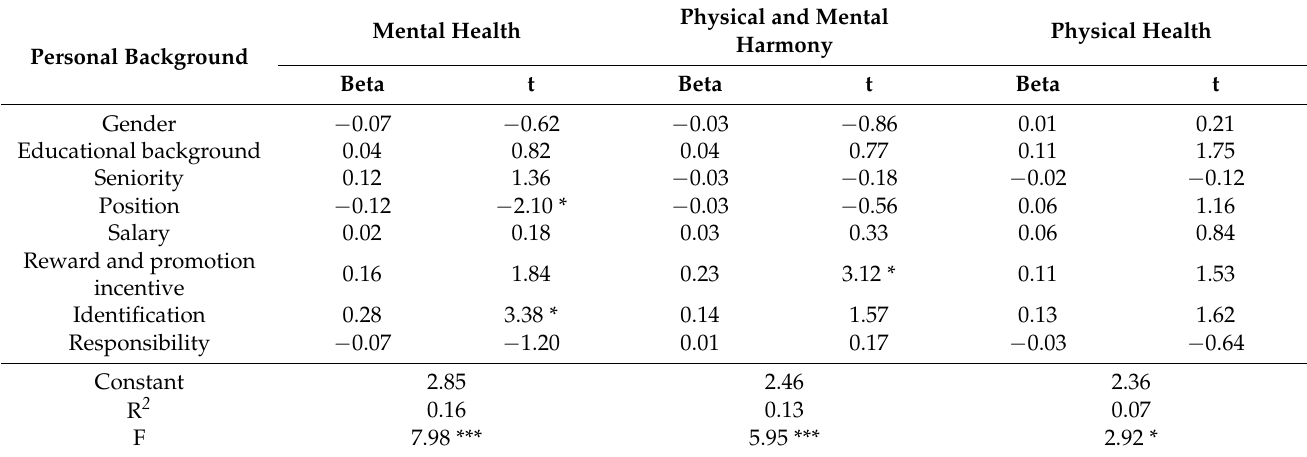
Table 5. Multiple regression analysis of wellness, personal background factors, and organizational climate.